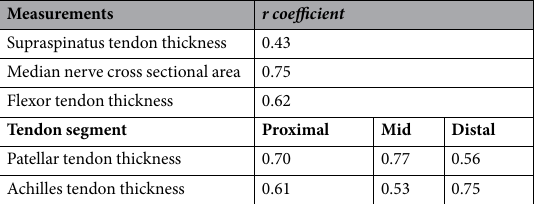
Table 2. Pearson’s correlation index between the measurements performed with the palmar sonographic machine and those with the high-end sonographic